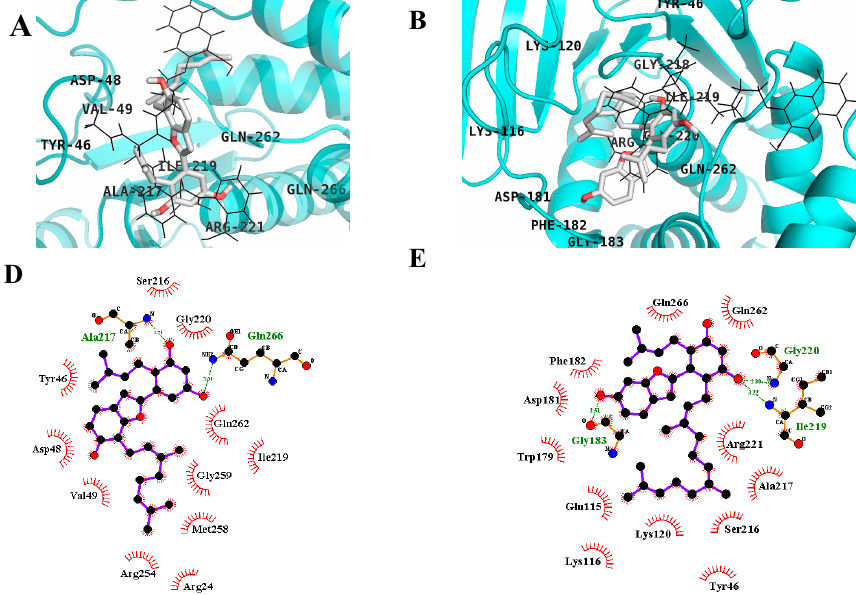
Figure 4. Binding mode for the PTP1B active site with reported inhibitor compound C (black line) by MD ( A ) and MB ( B ). 2-D ligand interaction diagram of PTP1B catalytic inhibition by MD ( D ) and MB ( E ). Dashed green lines indicate H-bonds. Carbon is in black, nitrogen is in blue, and oxygen is in red. Table 2. In silico docking results of selected compounds.